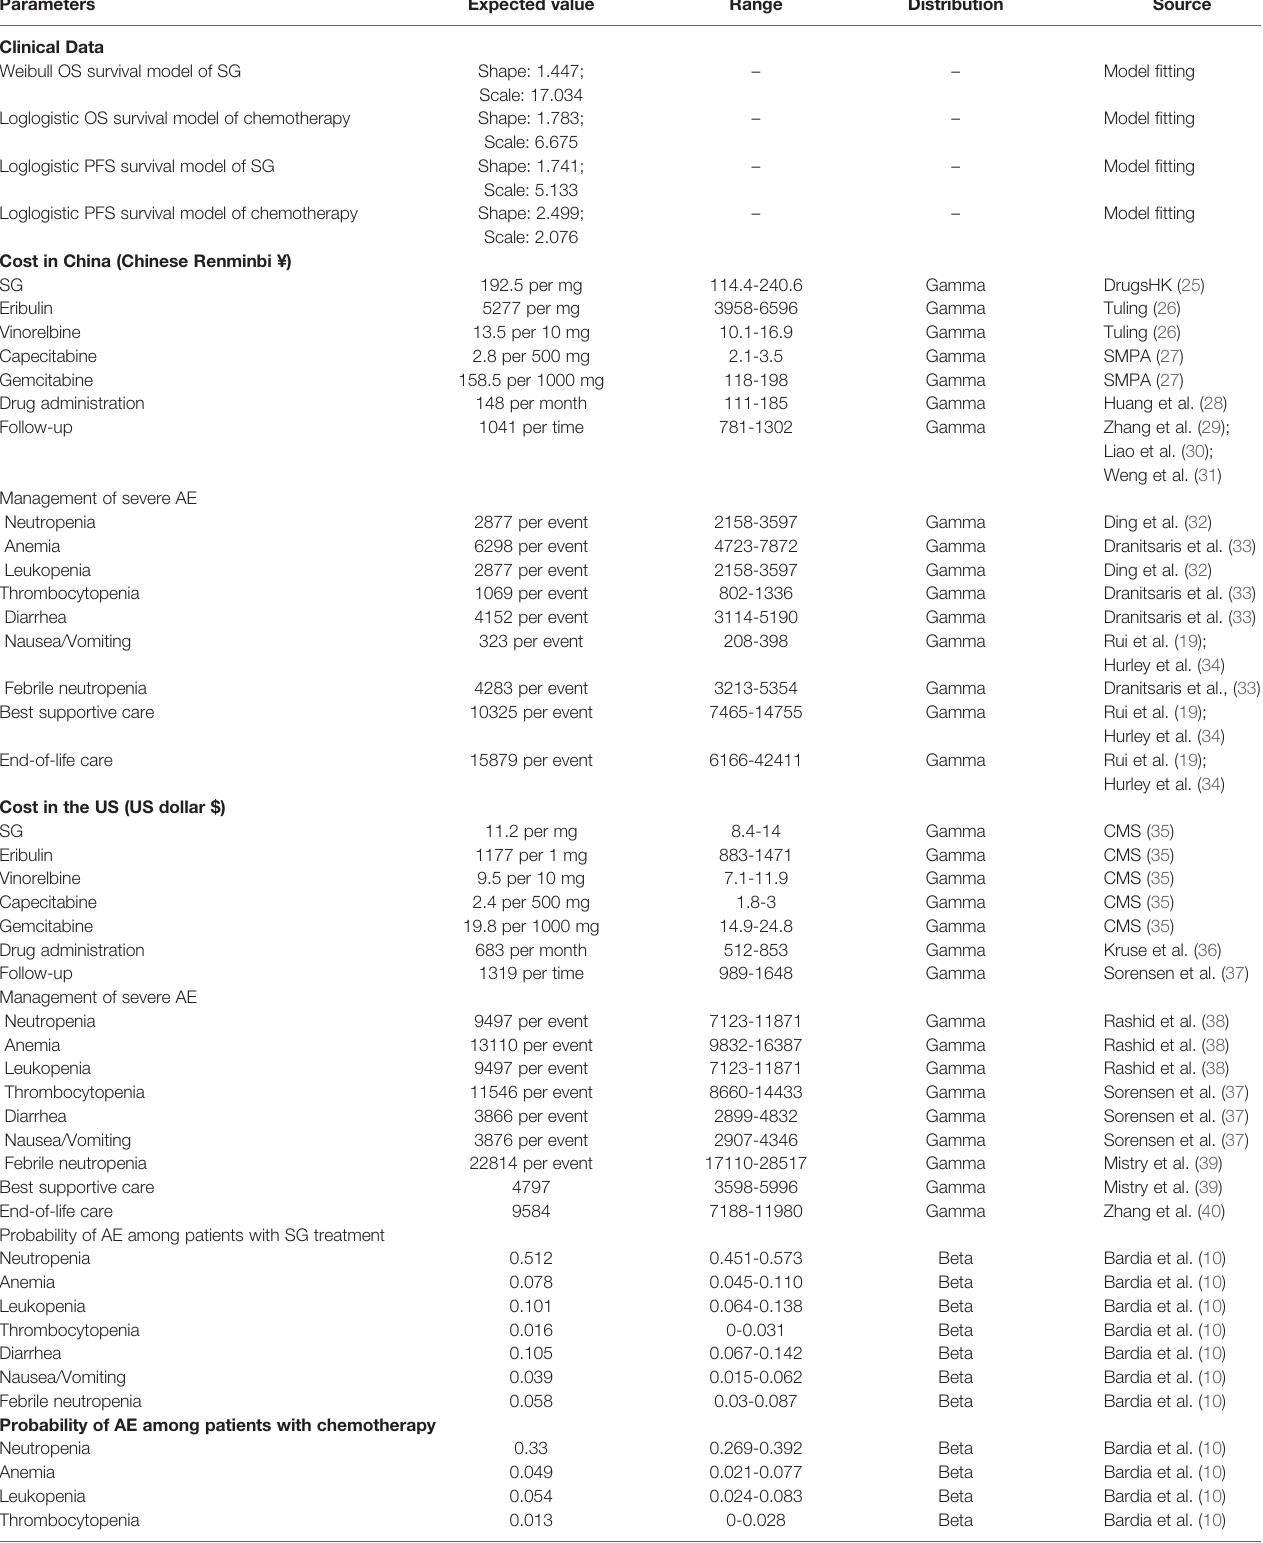
TABLE 1 | Basic parameters input to the model and the ranges for sensitivity